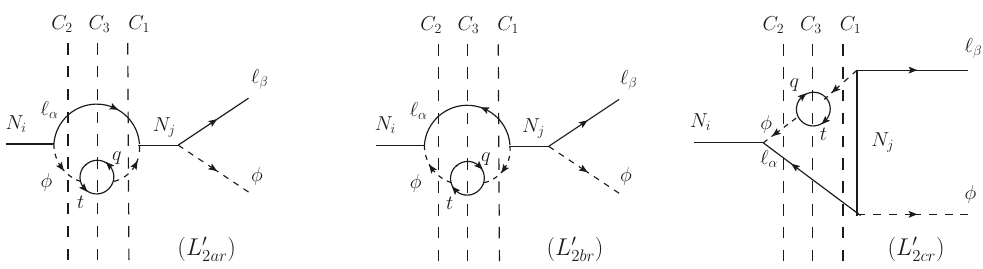
Figure 4 . An additional set of diagrams contributing to the CP asymmetry in two-body decays. The notation follows the conventions explained in the caption of (cid:12)gure